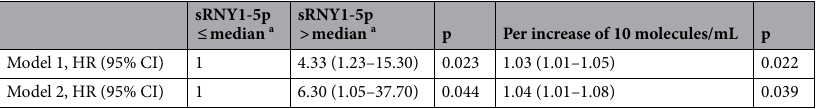
Table 3. Risk of acute coronary event as a function of sRNY1-5p levels. Model 1: adjusted for age, smoking, hypertension, diabetes and dyslipidemia. Model 2: Model 1 plus systolic and diastolic blood pressure, total cholesterol and HDL-C. HR (95% CI) hazard ratio (95% confidence interval). a sRNY1-5p median value is 631 molecules/mL of serum.